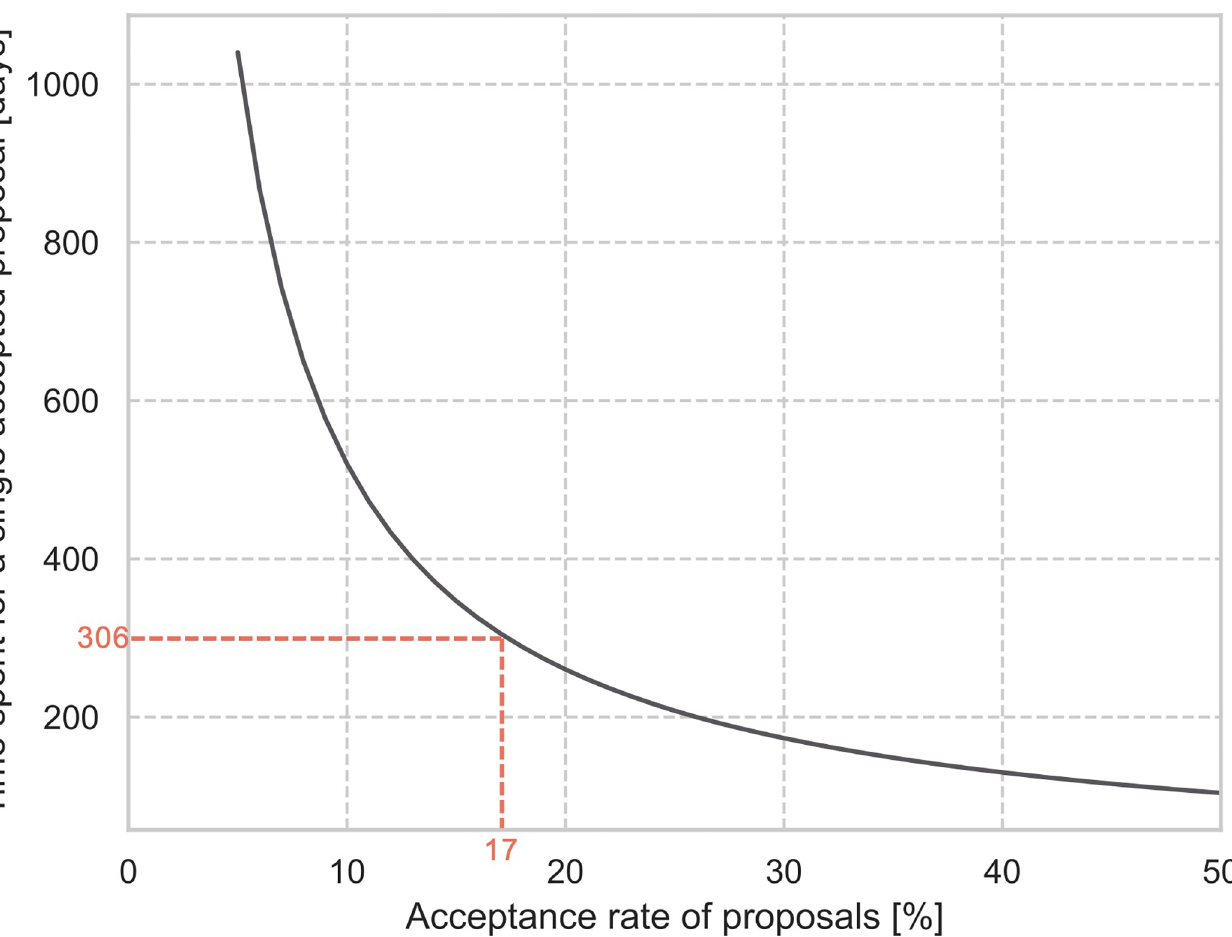
Fig 8. The time required to write hypothetical proposals as a function of the acceptance rate in order to fund a single hypothetical project. The acceptance rate of 17% is the acceptance rate of the research call Energieforschung in 2018 [29].